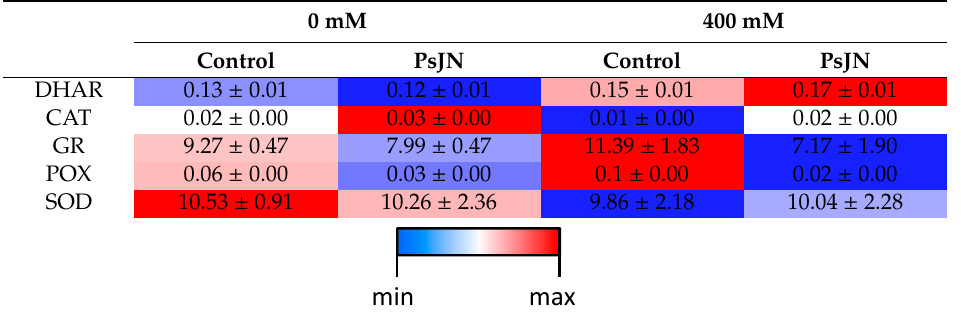
min max Dark red color indicates highest, dark blue color lowest values of individual parameters. Numbers are mean ± S.E. ( n = 4) [nkat / g FW], derived from three biological replicates of three technical replicates are mean ± S.E. ( n = 4) [nkat /g FW], derived from three biological replicates of three technical replicates each.